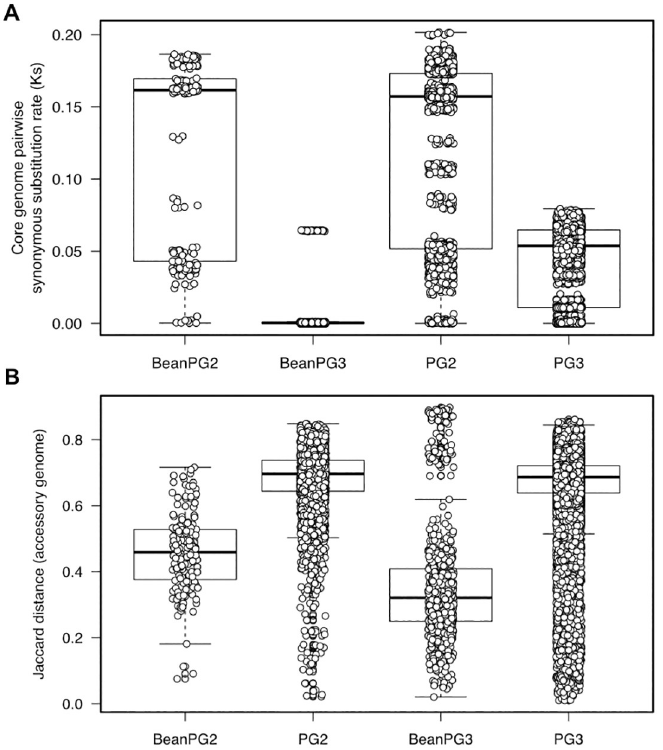
Fig 1. Core and accessory genome diversity. Comparison of (A) core genome synonymous substitution rate (Ks) and (B) accessory genome Jaccard distance for 21 PG2 bean isolates, 36 PG3 bean isolates, and all 66 isolates from PG2 and 142 isolates from